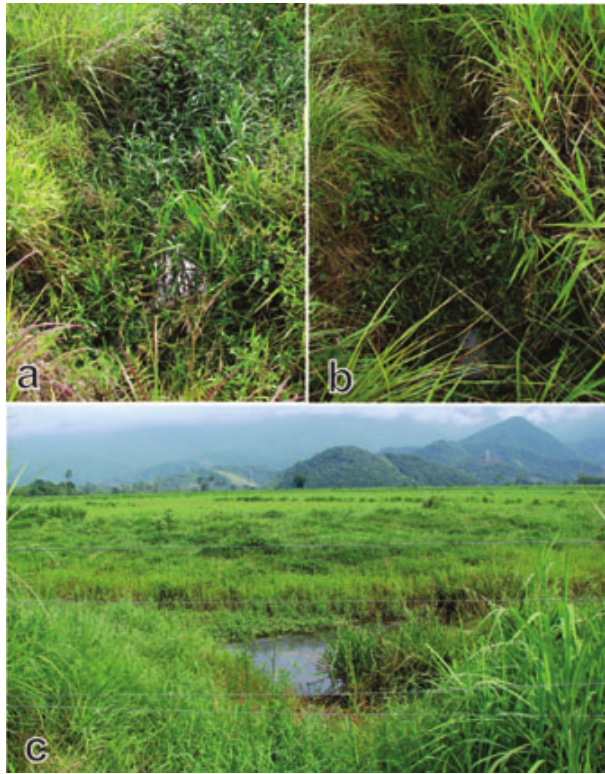
Fig. 8. Photographs of ( a ) small stream, ( b ) an adjacent pool, type locality of Listrura costai , new species; Brazil, Rio de Janeiro State, Angra dos Reis Municipality, swamp area close to the road RJ-155 (Angra-Lídice), about 1 km from road BR- 101, rio Jurumirim basin, 22°55’24.7”S 44°18’37.5”W. ( c ) The same stream just across the road where L. costai was not caught. Photos by Henrique Lazzarotto.